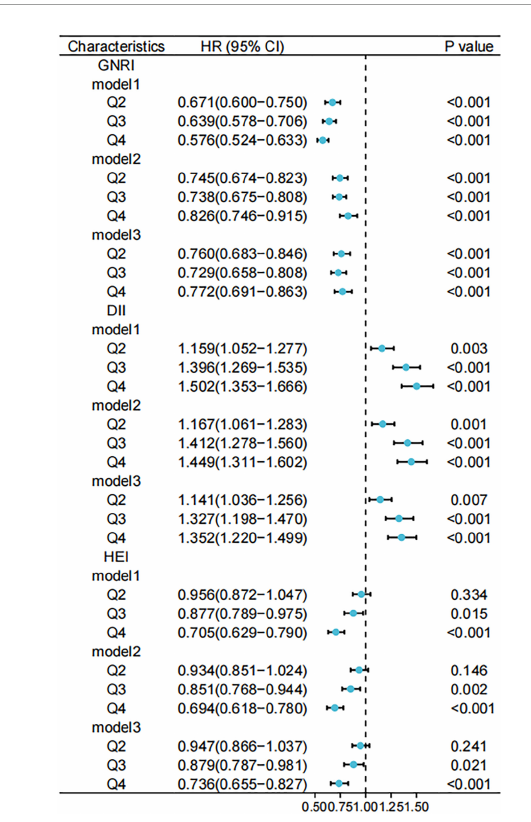
FIGURE4 Relationship between different scores and risk of all-cause mortality. Standardized scores were divided into four groups (Q1, Q2, Q3, and Q4) according to the 25th, 50th, and 75th quartiles, with the Q1 group used as a reference. Model 1 was unadjusted for variables and Model 2 was adjusted for age, sex, race, marital status, and household income at baseline; Model 3 was further adjusted for history of hypertension, hyperlipidemia, and diabetes. GNRI, geriatric nutritional risk index; DII, dietary inflammatory index; HEI, healthy eating index.